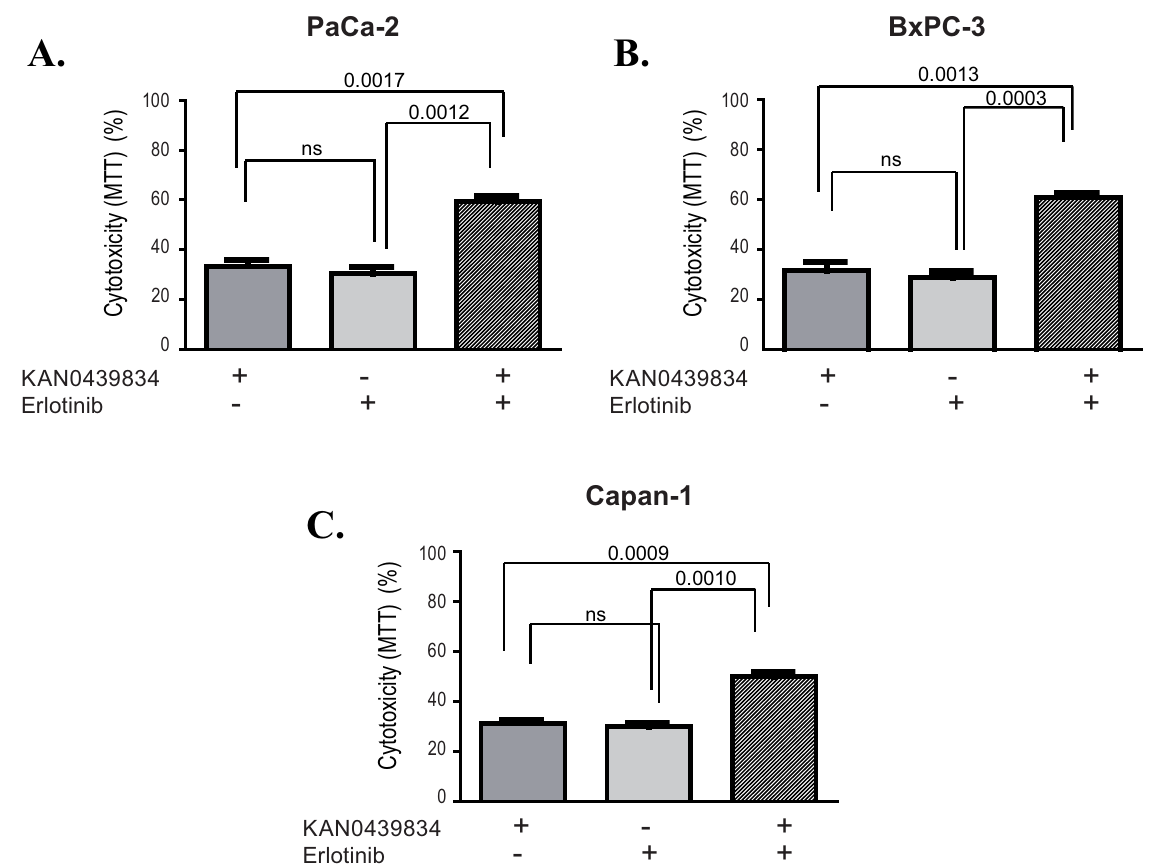
Fig 5. Cytotoxicity (%) (mean ± SEM) of three pancreatic cell lines cultured (72 h) with KAN0439834 and erlotinib alone and in combination using EC 30 value concentrations for the different drugs and cell lines respectively. Statistics are shown at the top.